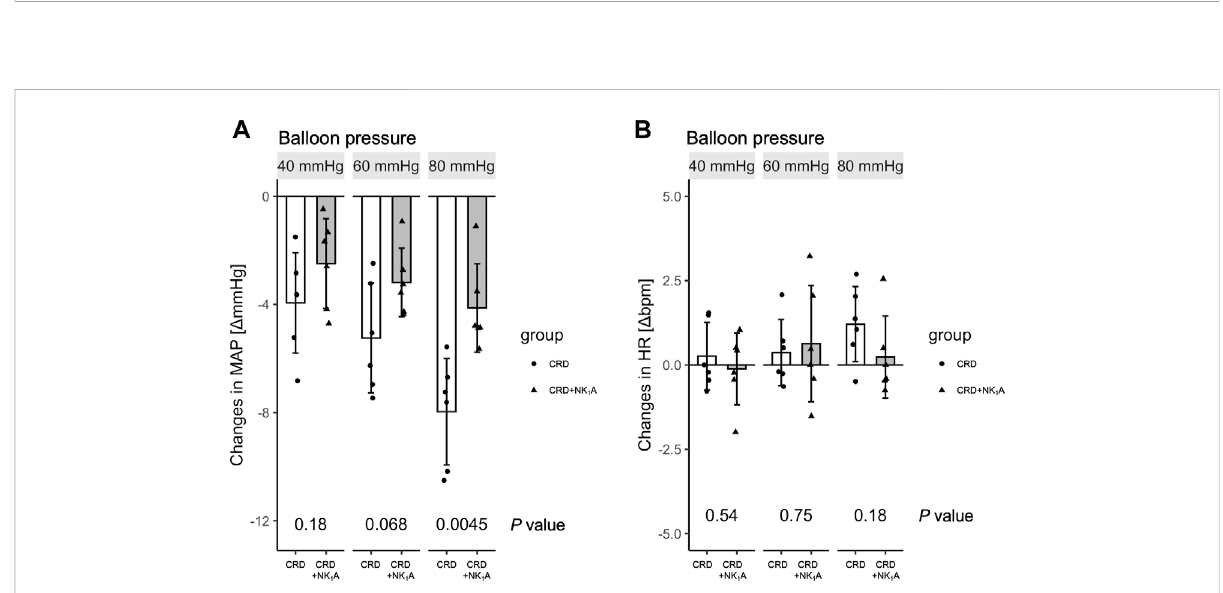
FIGURE 2 Changes in mean arterial pressure (MAP) and heart rate (HR) pre-and post-colorectal distension are shown in (A) and (B) , respectively. The distension procedure was performed at balloon pressures of 40, 60, and 80 mmHg. Group CRD received saline, and Group CRD + NK 1 A received fosaprepitant (30 mg/kg) intraperitoneally 40 min before the procedure. Data are expressed as mean ± standard deviation. p values: compared between groups using Welch ’ s t